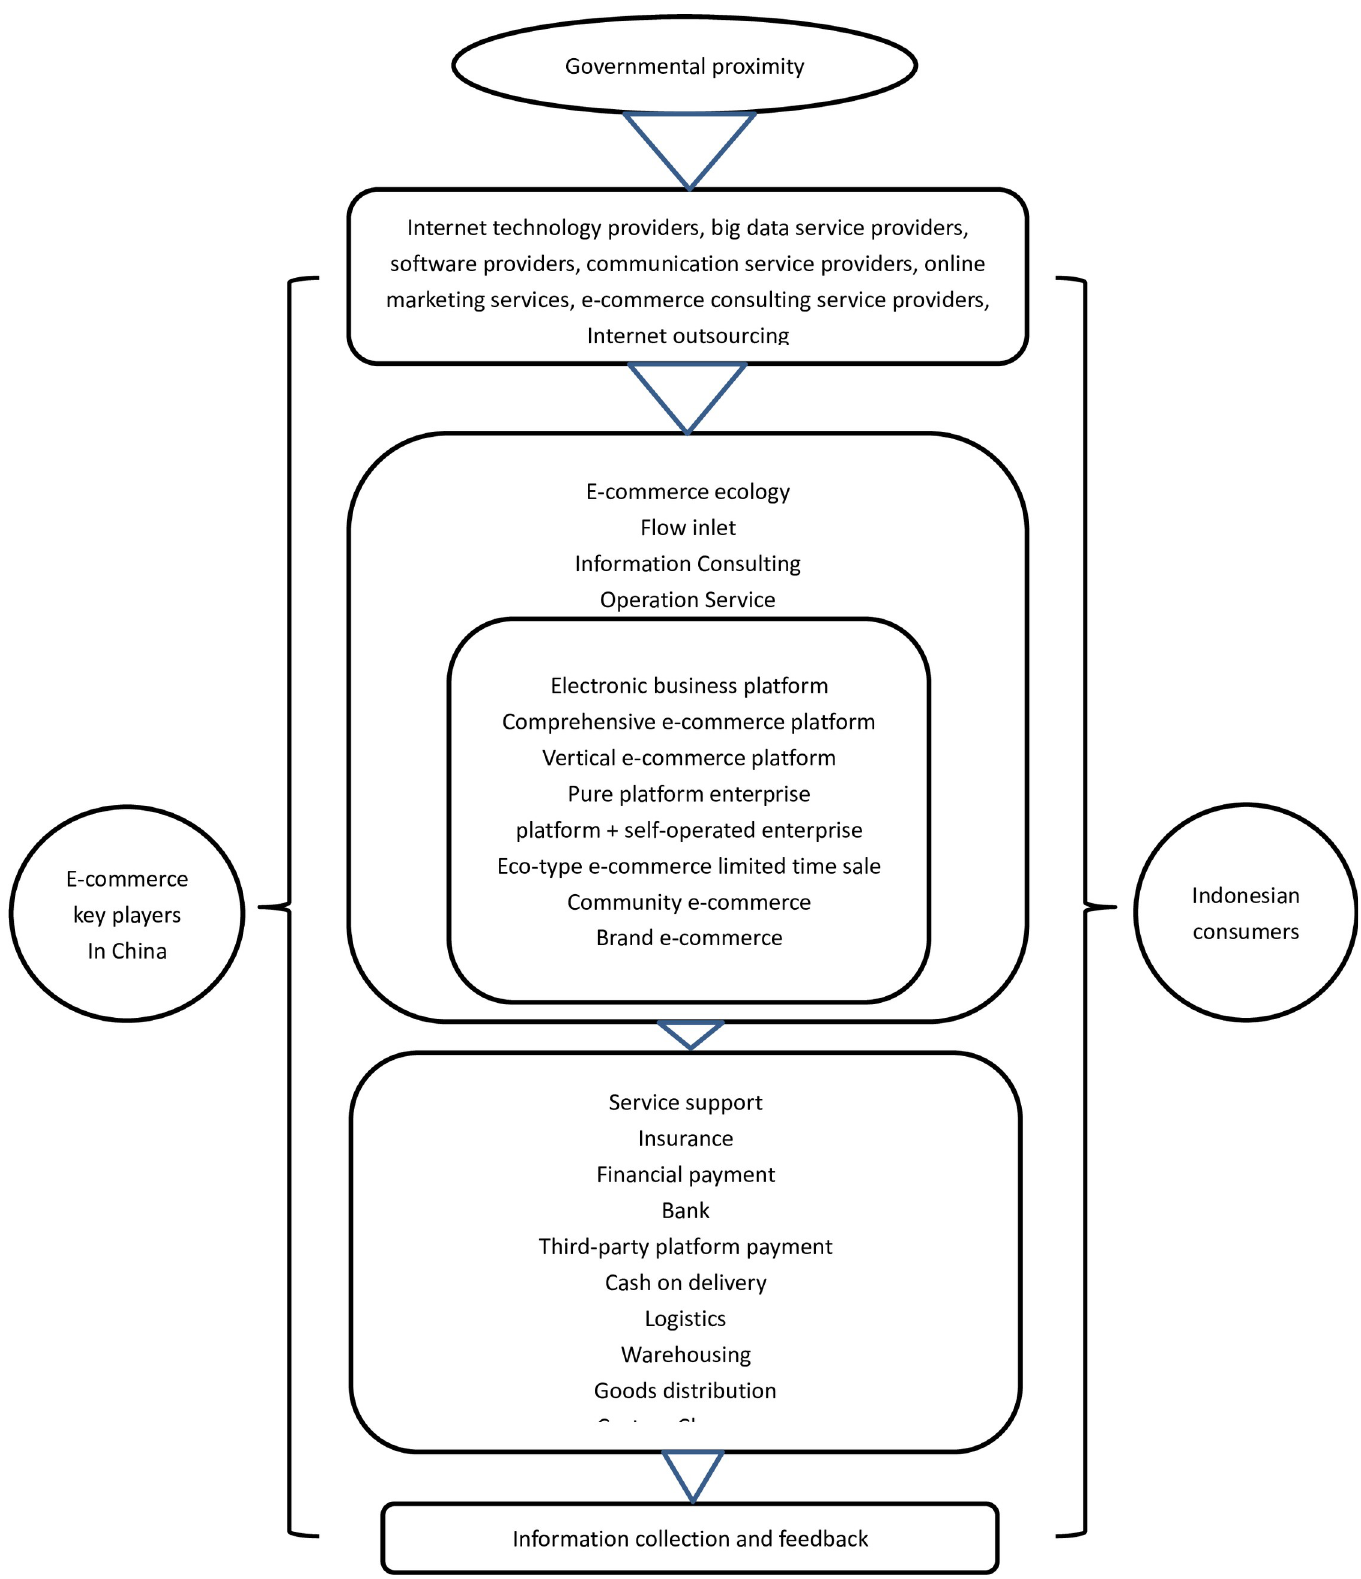
Fig 2. E-commerce value chain circle between China and Indonesia (summarized by the authors). https://doi.org/10.1371/journal.pone.0256837.g002 PLOS ONE | https://doi.org/10.1371/journal.pone.0256837 September 27,